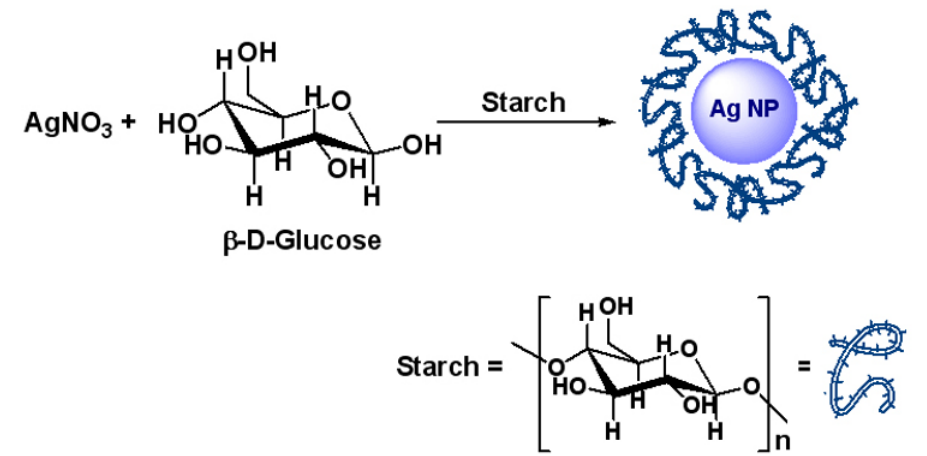
Figure 3. Green method for the synthesis of Ag